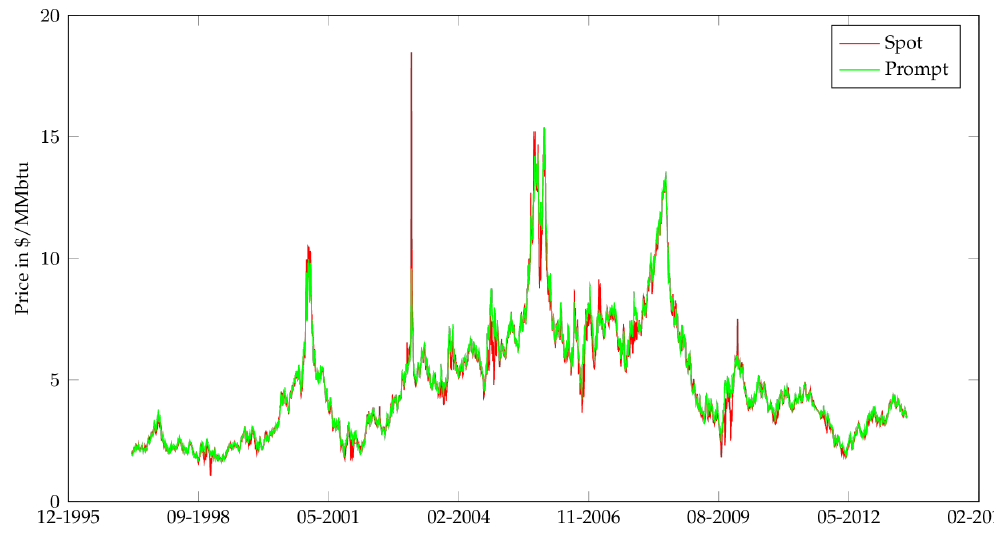
Figure 2. Spot and prompt historical